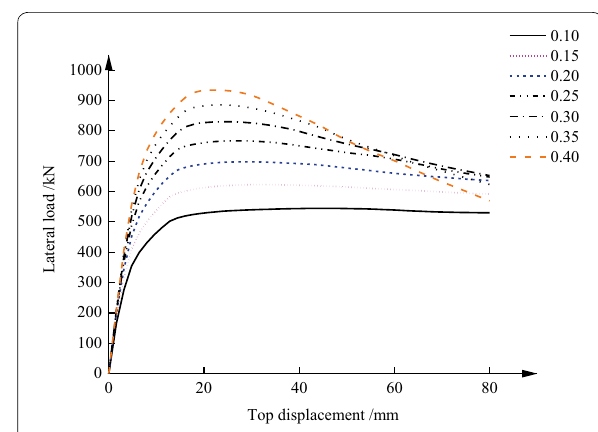
Fig. 16 Effect of axial compression ratio on load–displacement